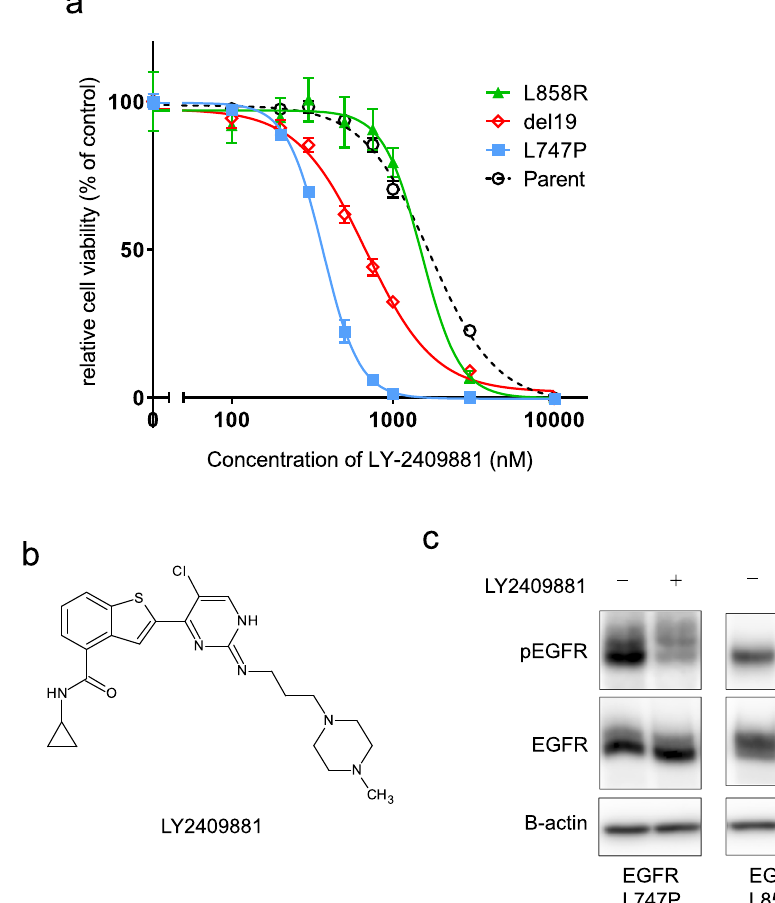
Fig. 5 Identi fi cation of LY2409881 as a potent EGFR-L747P mutant inhibitor. a Growth inhibition curve details. EGFR mutant expressing Ba/ F3 cells treated with serially diluted LY2409881. After 72 h of drug treatment, cell viability was measured using the CellTiter-Glo assay ( n = 3). b Chemical structure of LY2409881. c Inhibition of EGFR phosphorylation in the Ba/F3 cells expressing EGFR-L747P or EGFR-L858R mutation treated with 600 nM of LY2409881 for 3 h was evaluated by western blot with the indicated